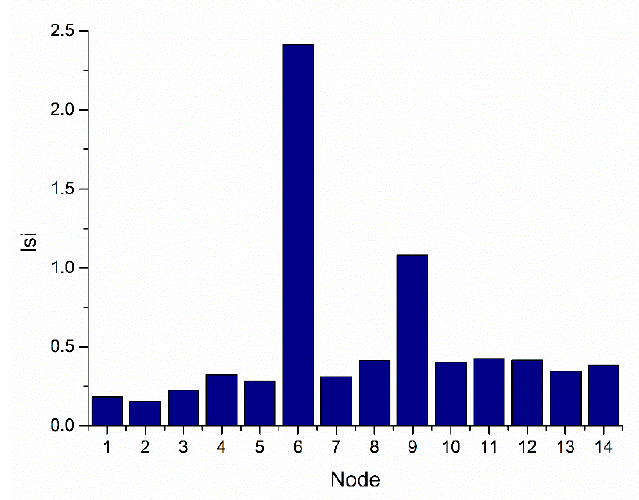
Figure 8. The load loss of every node.